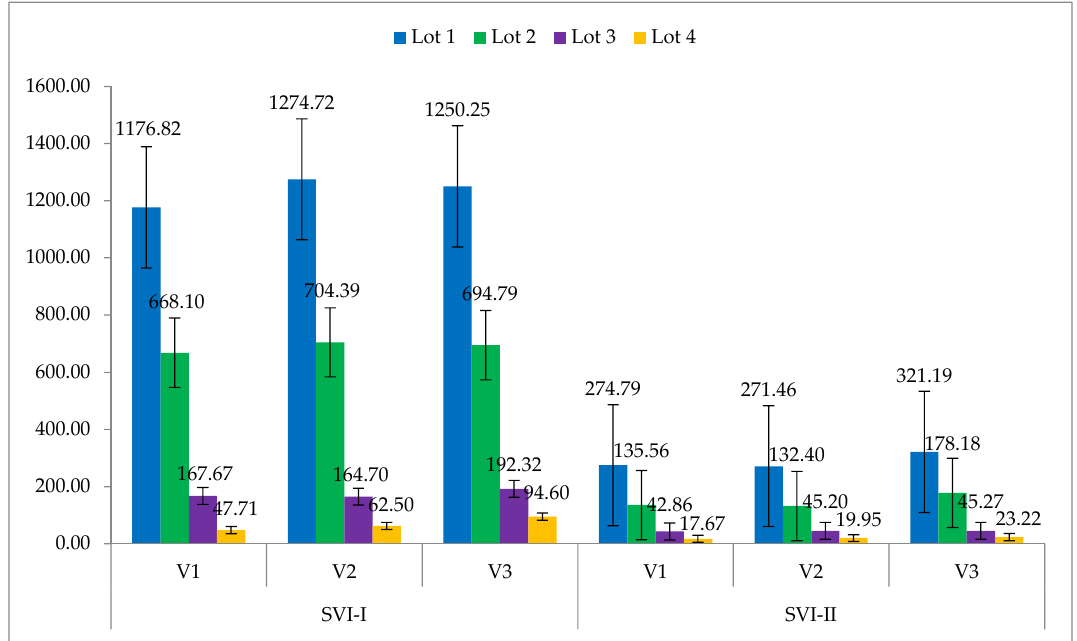
Figure 2. Effect of seed ageing on seed vigour indices. V 1 —Hisar-2; V 2 —Hisar onion 3; V 3 —Hisar onion 4; Lot 1—Fresh seed; Lot 2—One year old seed; Lot 3—Two year old seed; Lot 4—Three year old seed. Whereas, the y-axis indicates the scale (up to 1600) of the vigour indices.